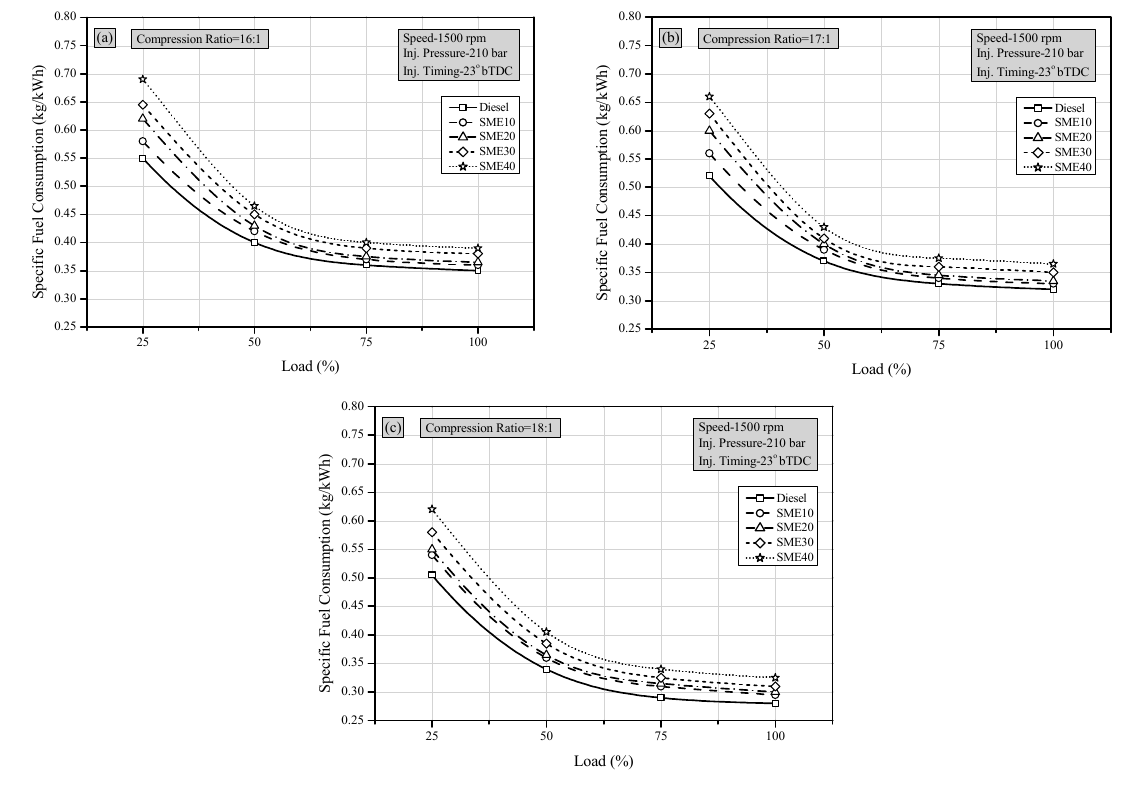
Figure 5. Variation of SFC with load for the fuel blends at CRs: ( a ) 16:1 ( b ) 17:1 ( c ) 18:1. Exhaust gas temperature (EGT) indicates the quantity of heat released in the final phases of combustion [57]. Numerous variables influence the EGT of a diesel engine, in- cluding the heat release rate, combustion duration, and impact of afterburning, and also the engine operating parameters, including CR and injection pressure [47]. The higher the EGT, the greater will be the heat loss from the engine and, as a result, the lower the BTHE. The variance in EGT for all fuel samples in response to engine load and CRs is shown in Figure 6. From the figure, it can be seen that, as the engine’s load increased, the EGT also rose, owing to the increasing fuel quantity in the engine [57]. In comparison to diesel, the blends had higher EGT values. This may have been attributable to the delayed burning of high viscosity blends, and the effects of unburned fuel, which raised EGT in the pre-mixed combustion phase. Additionally, the increased heat loss of the blends also contributed to higher EGT [47]. From Figure 6, it can be seen that the EGT dropped as the CR increased. This may have been due to the compressed air entering the suction stroke at a higher CR, which raised the air temperature. The higher the air temperature, the more the fuel atom- izer, resulting in complete combustion and decreased EGT. At lower CRs, the EGT for all the fuel samples was noted to be higher because more heat is generated during the diffu- sion phase, resulting in a greater amount of heat being carried along with the exhaust gas [22]. CR 18:1 provided the lowest EGT of 314 °C, 329 °C, 338 °C, 352 °C, and 363 °C for diesel, SME10, SME20, SME30 and SME40, respectively.